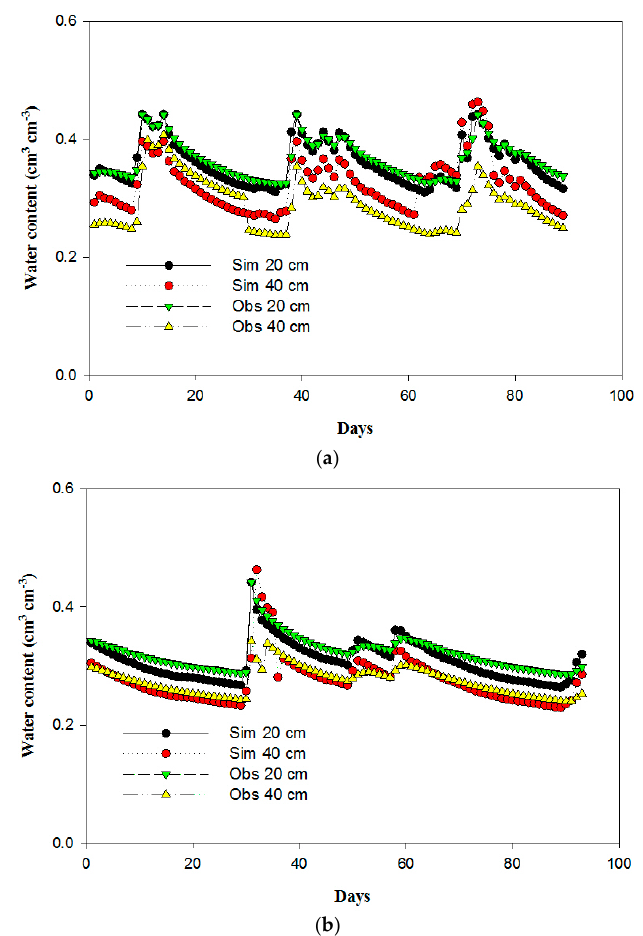
Figure 4. Simulated and observed soil water content within root zone (0–40 cm) during the ( a ) off-season and ( b ) main season.